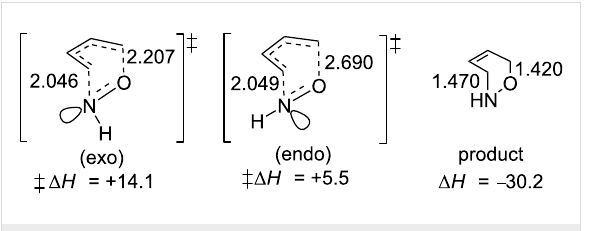
Figure 2: RB3LYP/6-31G* computed energies (in kcal·mol − 1 ) and bond lengths for exo and endo -transition states and the product of the nitroso hetero-Diels–Alder reaction between HNO and